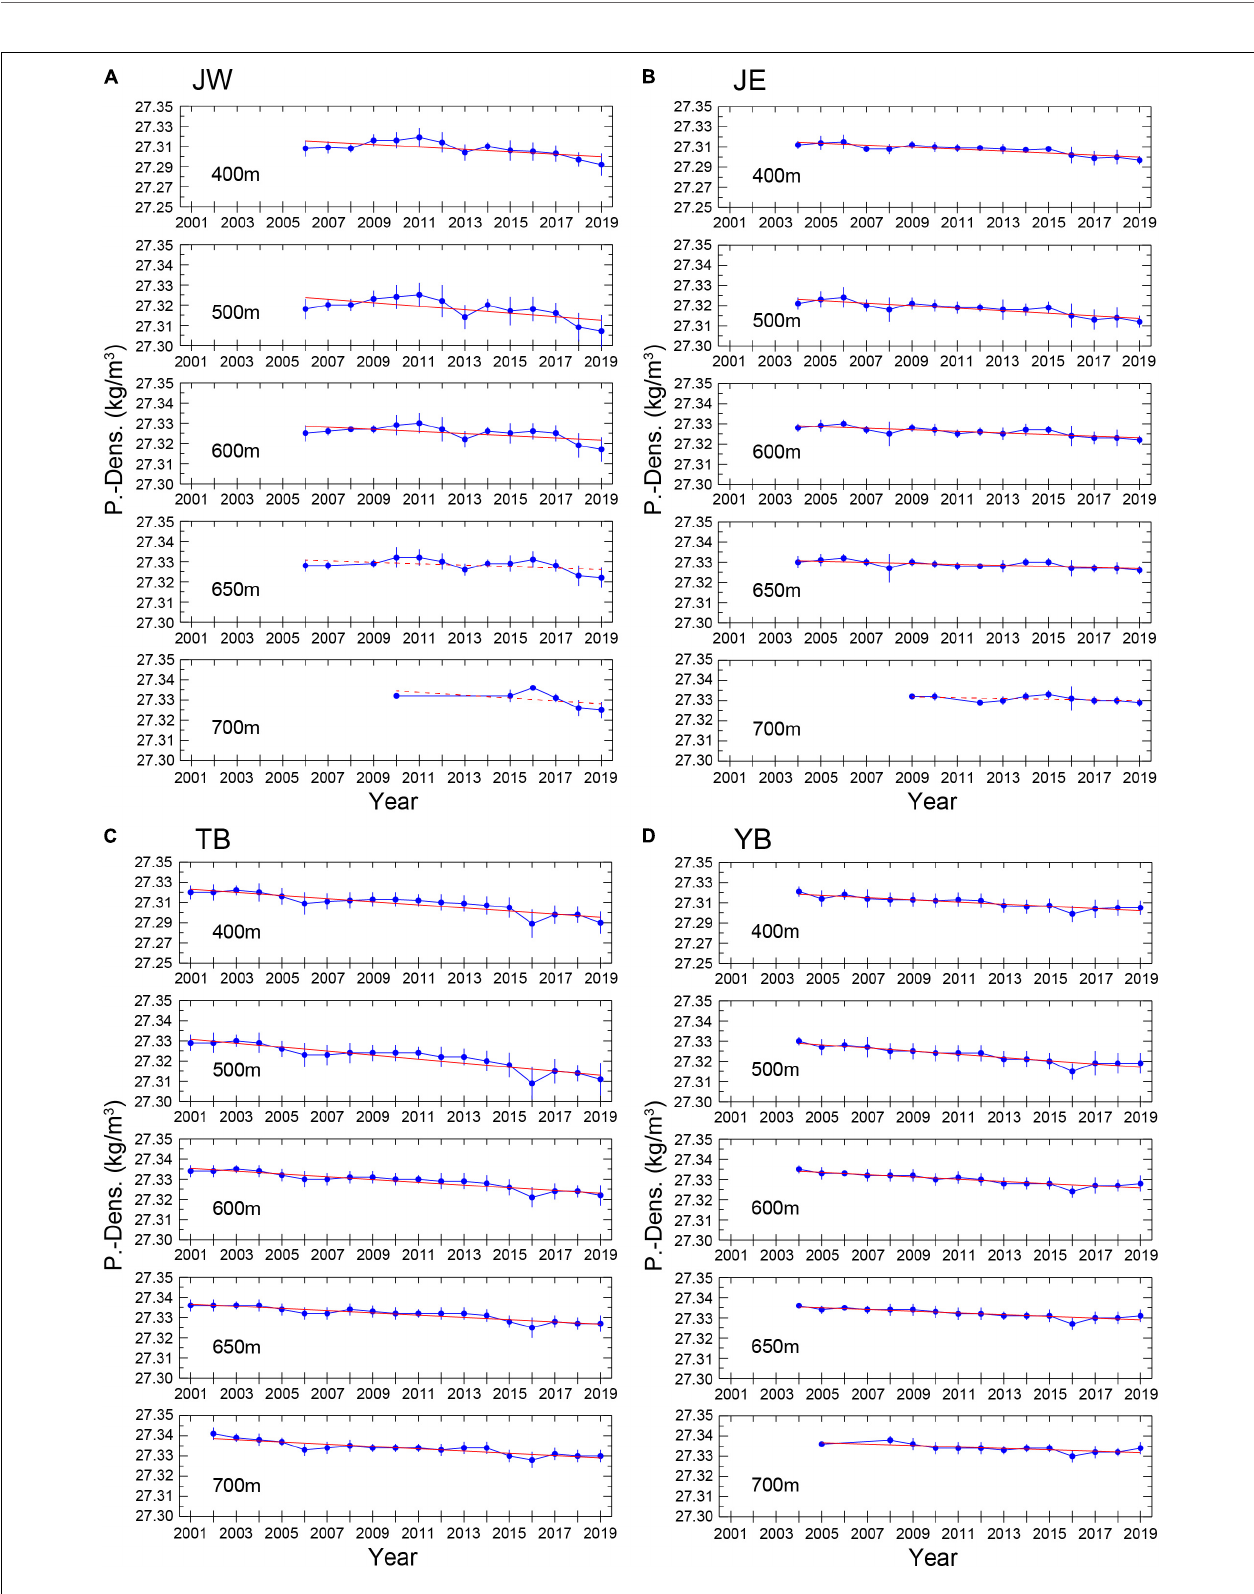
FIGURE 5 | Time series of the Argo-based yearly mean PD at 400, 500, 600, 650, and 700 m in (A) JW, (B) JE, (C) TB, and (D) YB. Vertical bars at each data point indicate one standard deviation. Red lines depict the linear trend calculated by least square method. Statistically insignificant trends at 95% confidence level are shown by dashed